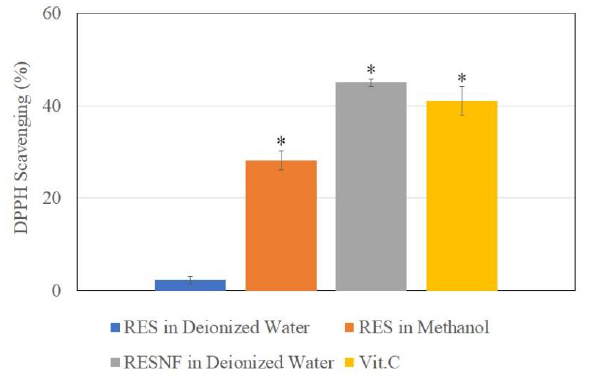
Figure 5. DPPH free radical scavenging activity of resveratrol in deionized water, resveratrol in methanol, resveratrol nanofibers (RESNF) in deionized water, and vitamin C at 10 µ g / mL concentration. Results are shown as mean ± SEM of three independent experiments. * represents P < 0.05 when compared to resveratrol in deionized water.